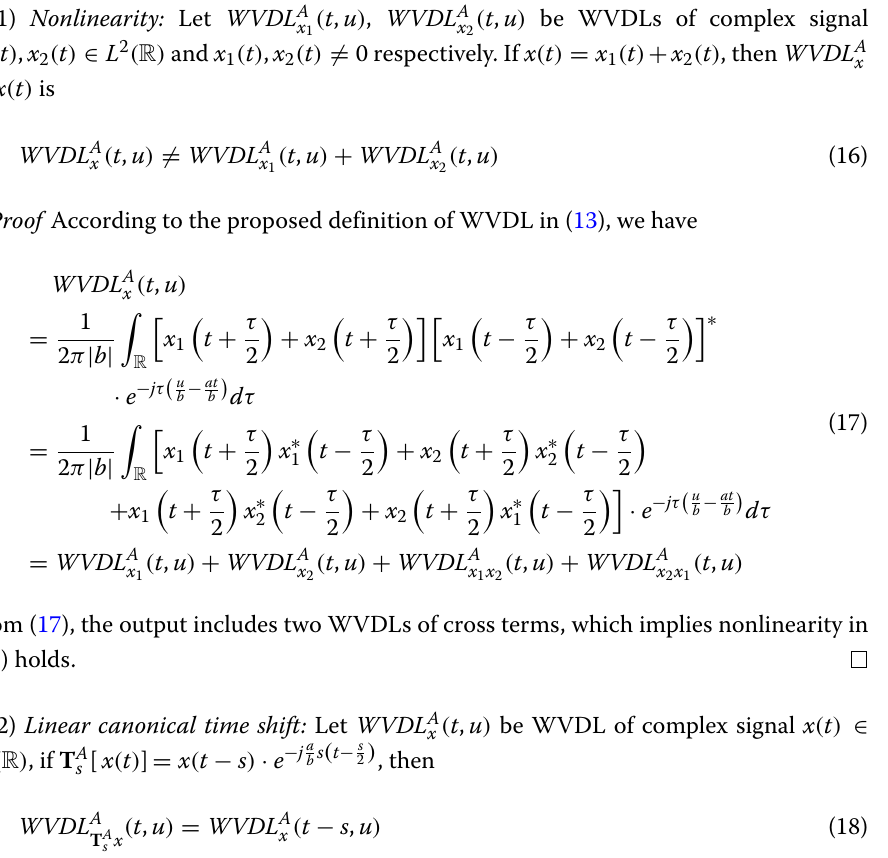
Table 4 Other useful properties of new WVDL Property Formula